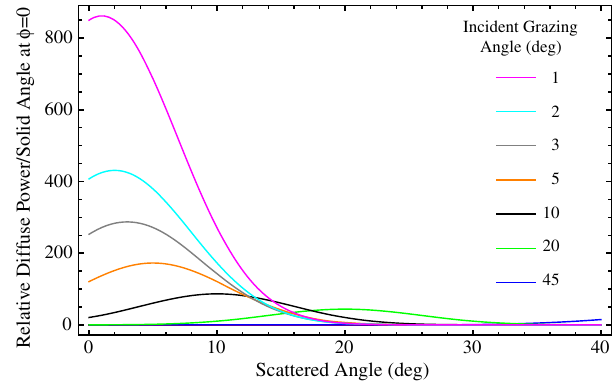
FIG. 7. Diffuse scattering polar angular distributions for high energy photons, σ ¼ 200 nm and T ¼ 5500 nm. The curves are calculated from the approximate relation given in Eq. (3). In this case, high-energy photons correspond to λ ≪ σ , i.e., E ≫ 6